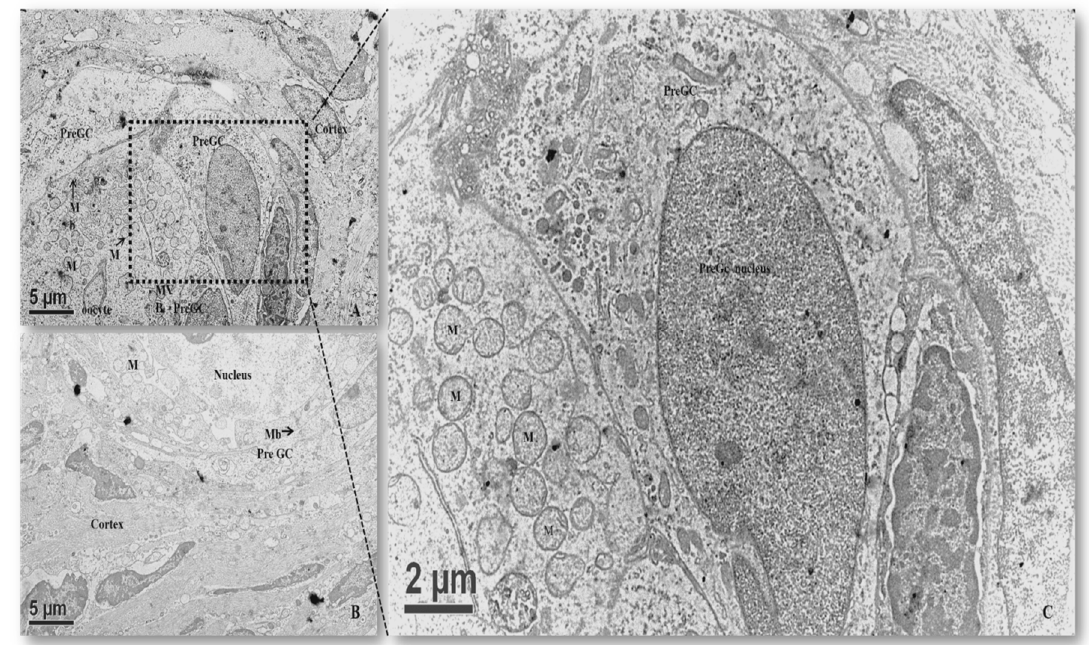
Figure 2. Transmission electron microscopic images of porcine primordial follicles showing the ultrastructure of oocytes and the associated cellular components: ( A ) a primordial follicle having juxtaposed flattened pregranulosa cells; ( B ) a primordial follicle with a voluminous eccentric oocyte nucleus (encompassed dot line); and ( C ) oocytes from the primordial follicles containing round and oval mitochondria with tiny cristae and electrodense matrices. Gc, granulosa cell; M, mitochondria; MV, mitochondria–vesicles complexes; Mb, cytoplasmic membrane.